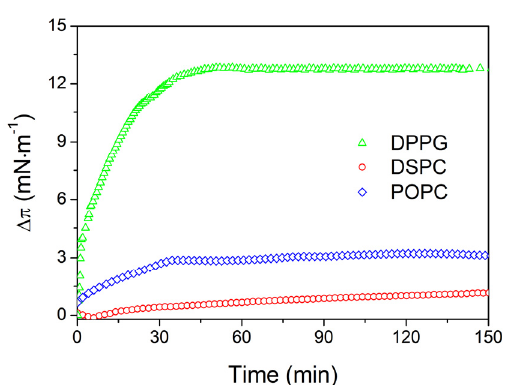
Figure 5. Kinetics of the adsorption process of the Fe 3 O 4 -AChit nanoparticles from the water subphase into the phospholipid membrane models recorded at the surface pressure equal to π = 35 mN·m − 1 .